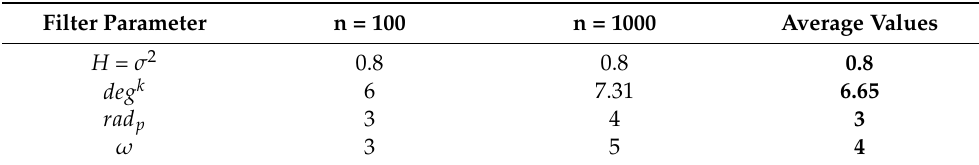
Table 2. Optimal values of the filter parameters based on the testing for 80 MR images from various datasets.